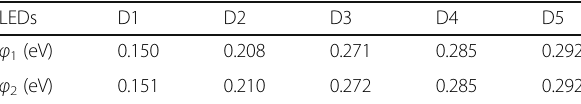
Table 2 Valence band barrier height for PNP-AlGaN junction of LEDs D1, D2, D3, D4, and